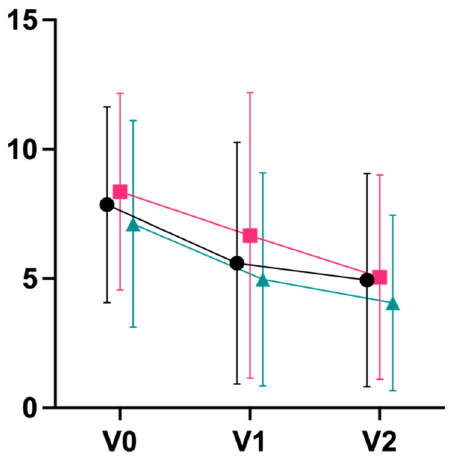
Figure 8. Anxiety HADS (Mean ± SD).